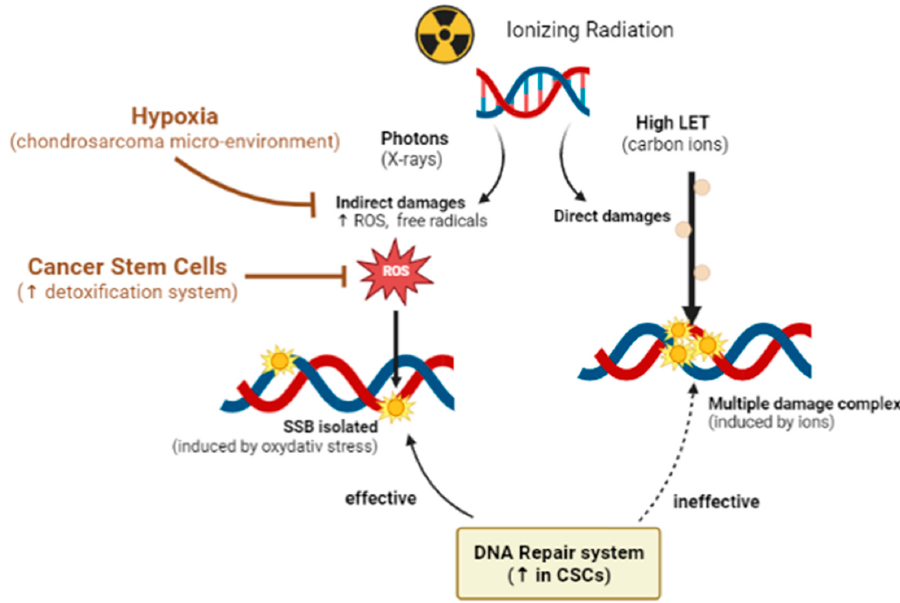
Figure 2. Benefits of High LET irradiations. In the case of ionizing radiations, X-rays induce mainly indirect damages, through the formation of free radicals and reactive oxygen species (ROS), which generate isolated DNA damages. As observed in the case of chondrosarcoma, hypoxia can reduce such damages. In case of high ROS levels, an enhancement of detoxification systems is triggered in cancer stem cells. High LET radiations, such as carbon ions, induce more direct complex damages, named localized multiple damage, independently of the oxygen level and more difficult to repair for cells.